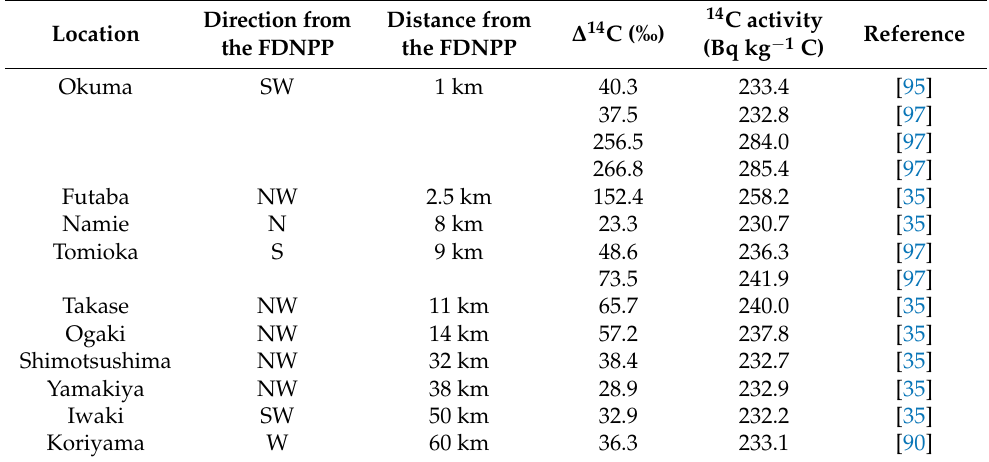
Table 2. Average measured radiocarbon activity in Japanese tree rings from